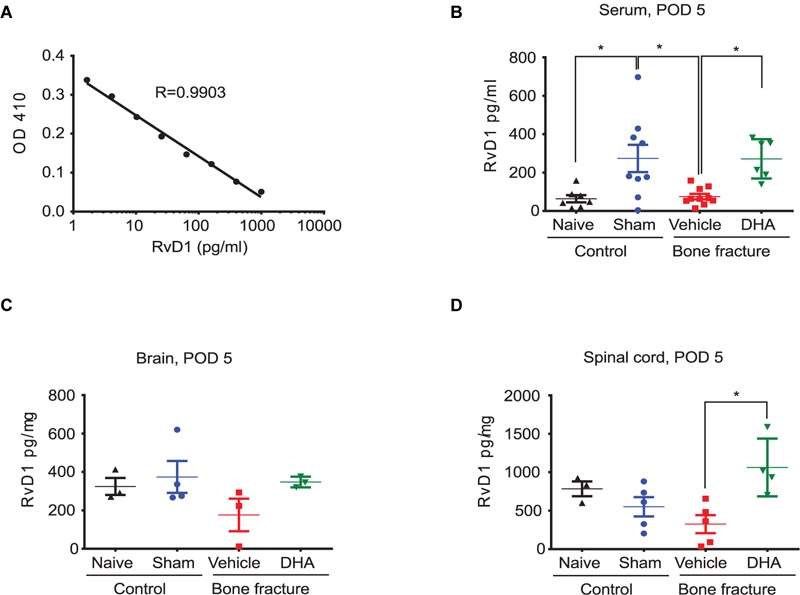
Perioperative DHA treatment increases RvD1 levels in serum and spinal cord. (A) RvD1 standard curve produced by the Cayman Chemical ELISA assay, demonstrating reliable measurements within the specified concentration range. RvD1 levels in serum samples (B), brain samples (C), and spinal cord samples (D) of naïve mice and mice after sham surgery or bone fracture with vehicle and DHA treatment (the same as described in Figure 1). Samples were collected at post-operative day 5 (POD 5). Note that RvD1 levels are elevated after sham surgery and in serum and spinal cord samples after the DHA treatment. ∗P < 0.05, one-way ANOVA; n = 3–10 mice per group. Data are presented as mean ± SEM.